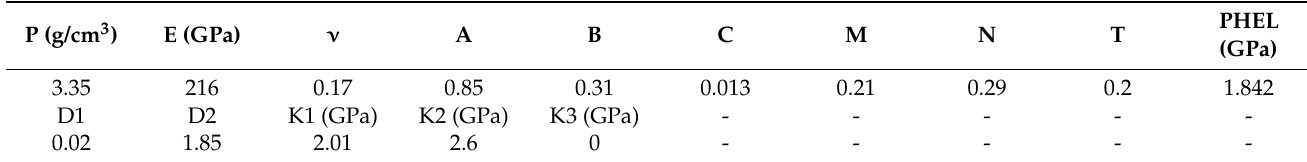
Table 4. Material parameters of Al 3 Ti layers [32].